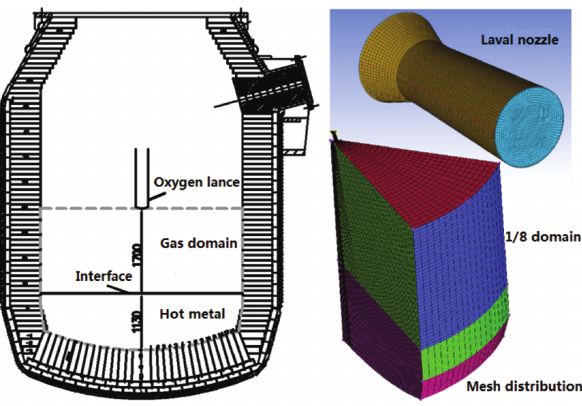
Figure 1: Geometric parameters of converter and mesh